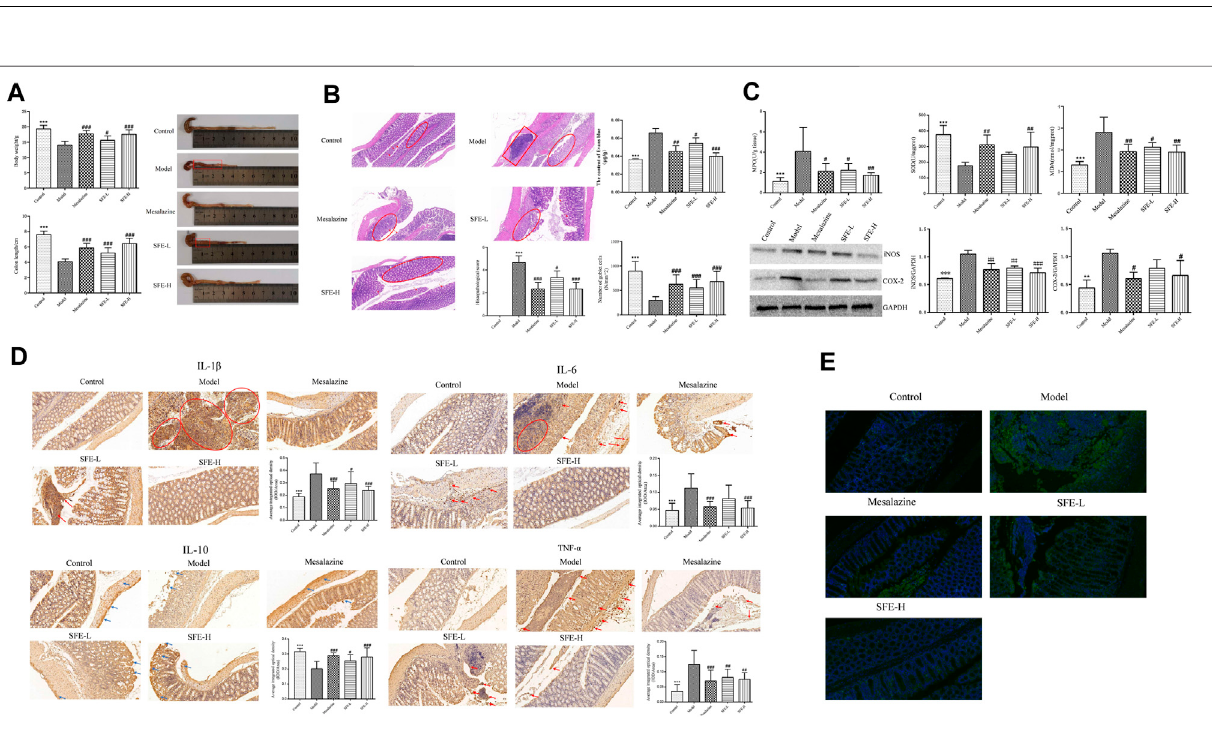
Frontiers in Pharmacology |